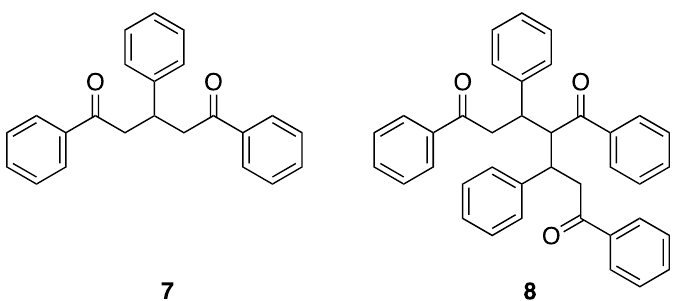
Figure 9. The structure of the 2:1 (ketone:aldehyde) pentane-1,5-dione that can arise from the reaction of acetophenone with benzaldehyde and the proposed structure of Kostanecki’s triketone the 3:2 adduct that formally arises from the nucleophilic addition of the enol of enolate of the pentane-1,5-dione on the 1:1 enone.